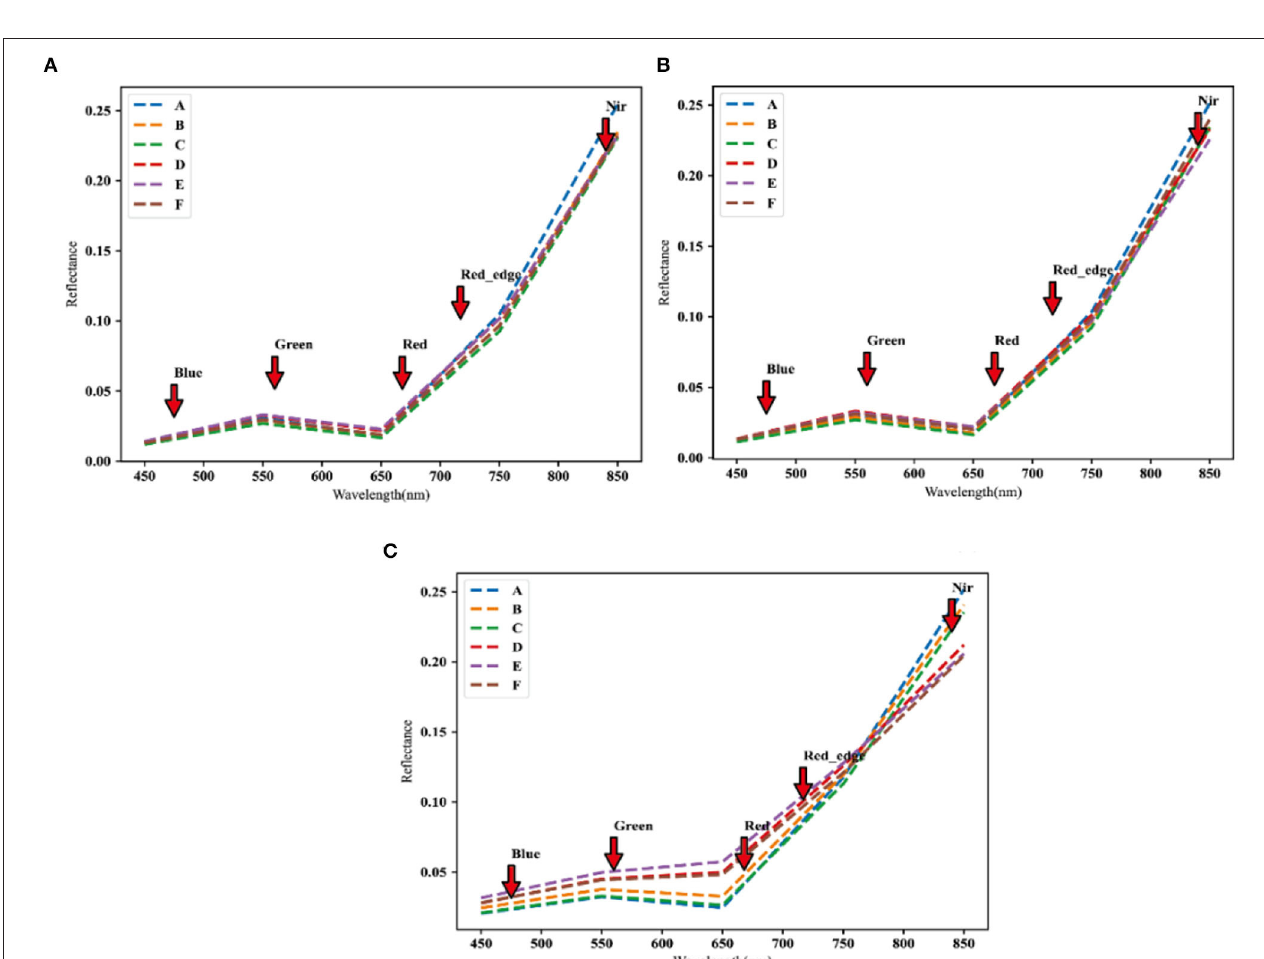
FIGURE 3 | Different spectral reflectance maps of five bands of Manas winter wheat drones at different growing stages: (A) Manas winter wheat heading stage; (B) Manas winter wheat flowering stage; and (C) Manas winter wheat filling stage. A–C denote three replicates under normal irrigation; D–F denote three replicates under water-limited